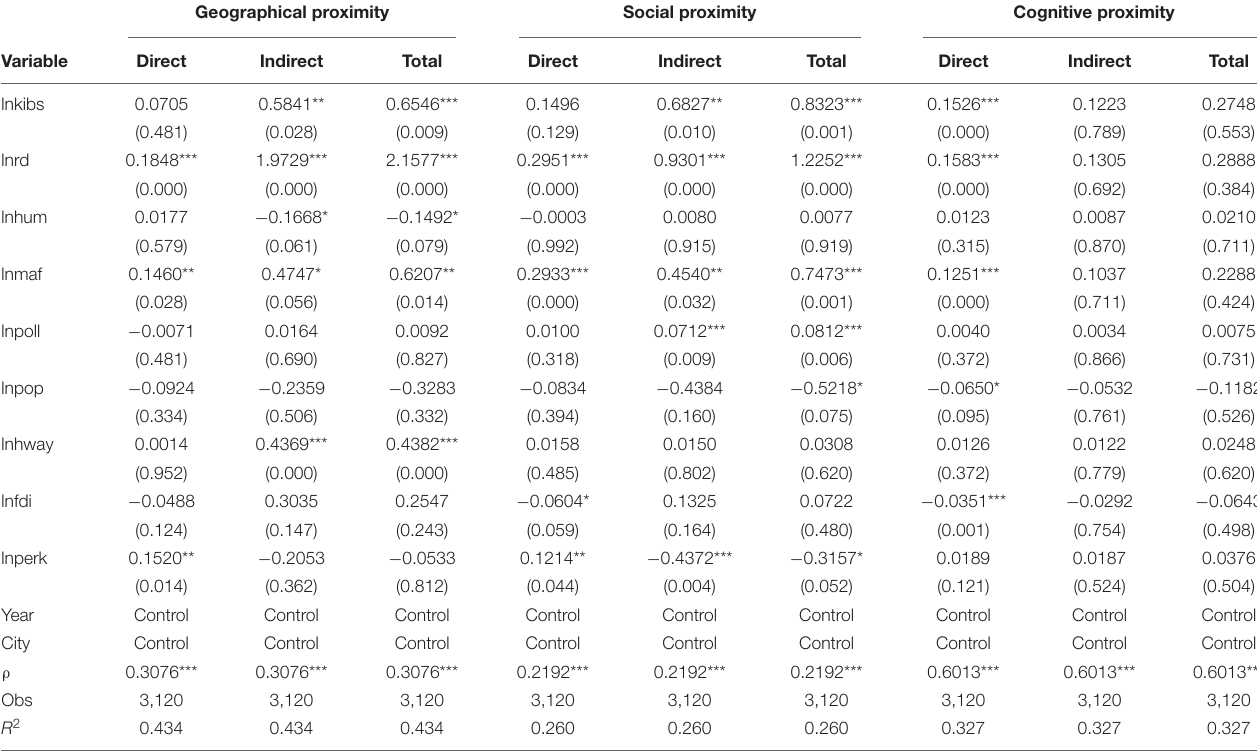
TABLE 3 | The innovation performance of knowledge-intensive services (KIBS)-manufacturing collaboration under a single dimension of proximity. Geographical proximity Social proximity Cognitive